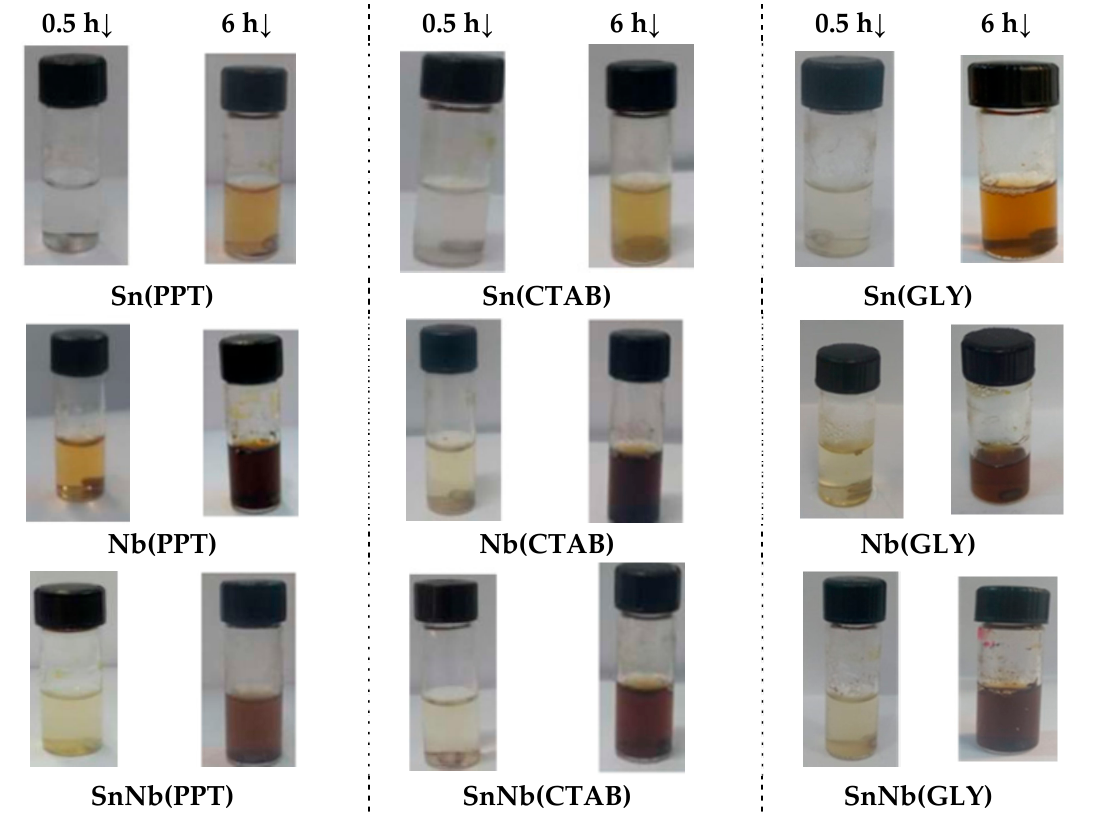
Figure 10. Visual aspects of the samples during the reaction using catalysts (1.5 × 10 − 3 g) at 150 °C (0.5 and 6 h).